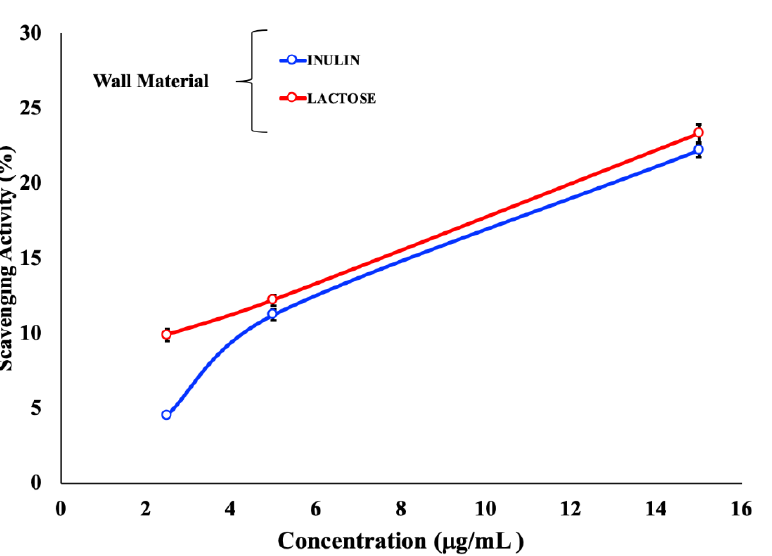
Figure 3. Effect of inulin and lactose matrices on the scavenging activity of co-microencapsulated B. clausii with resveratrol ( Bc LRSV and Bc INRSV).